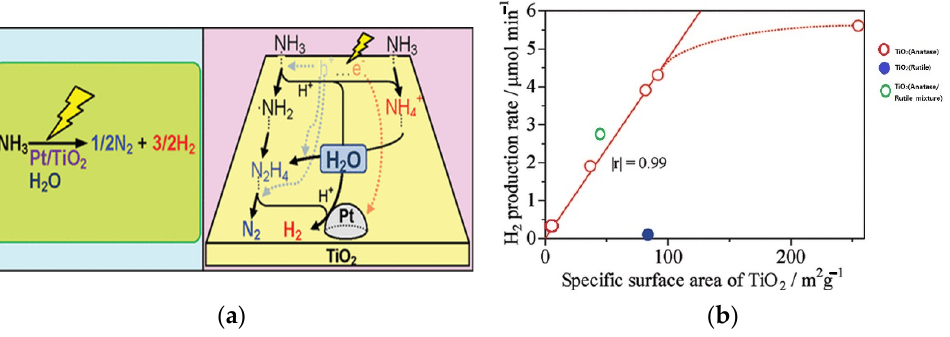
Figure 41. The hydrogen production over the platinum loaded titanium oxide photocatalysts: the highest product yield was obtained on the platinum loaded anatase. ( a ) variation of production rate with a specific surface area of catalyst ( b ). Reprinted with permission [116,143].